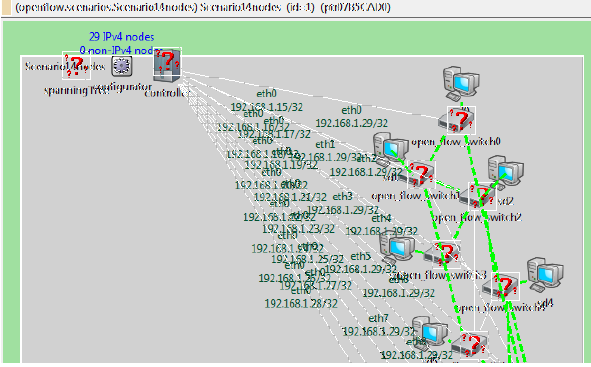
Figure 5. Main module: network Scenario14nodes .